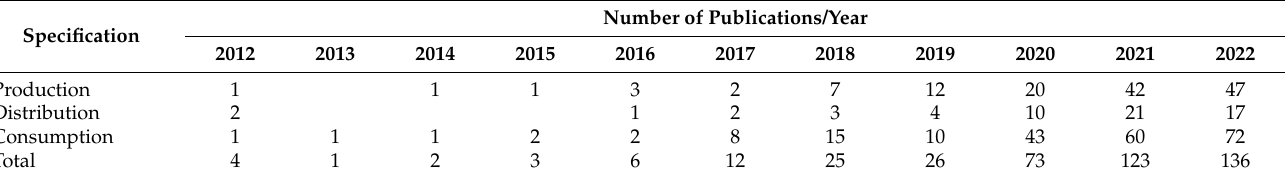
Table 2. Number of publications/year in each sector 1 .